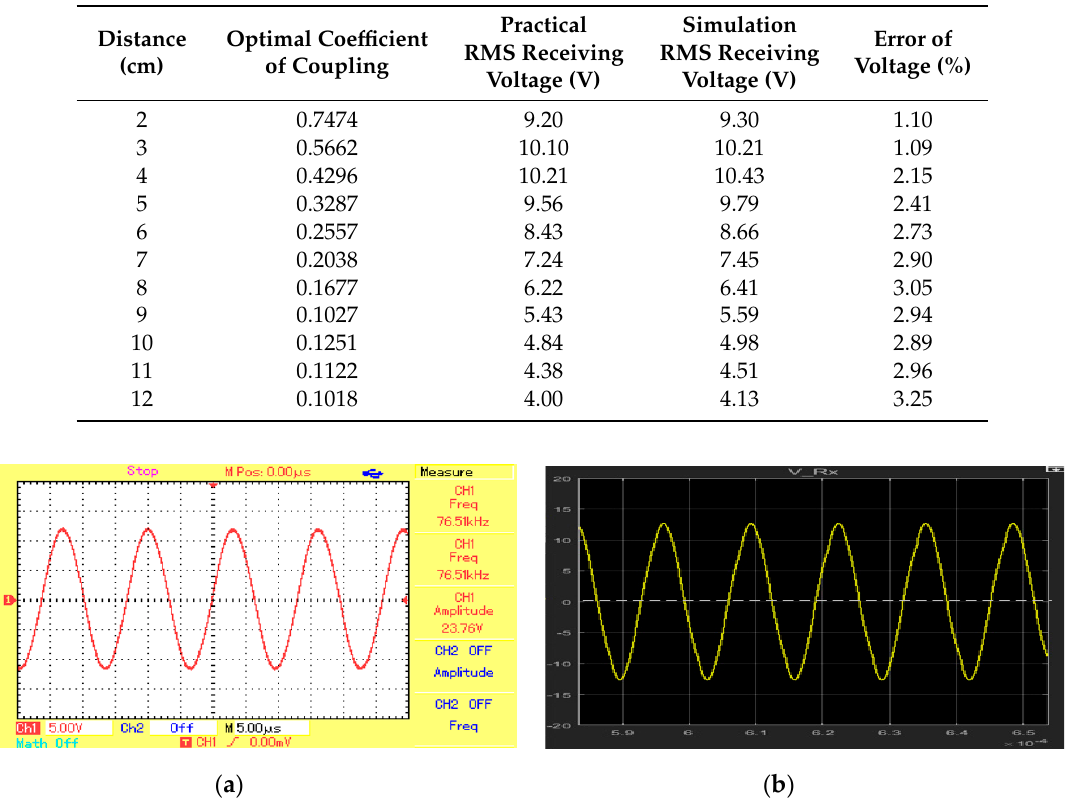
Figure 11. Receiving end voltage waveform at distance of 6 cm: ( a ) practical voltage waveform, ( b ) simulation voltage waveform. Table 4. Comparison between practical and simulation receiving RMS voltage.